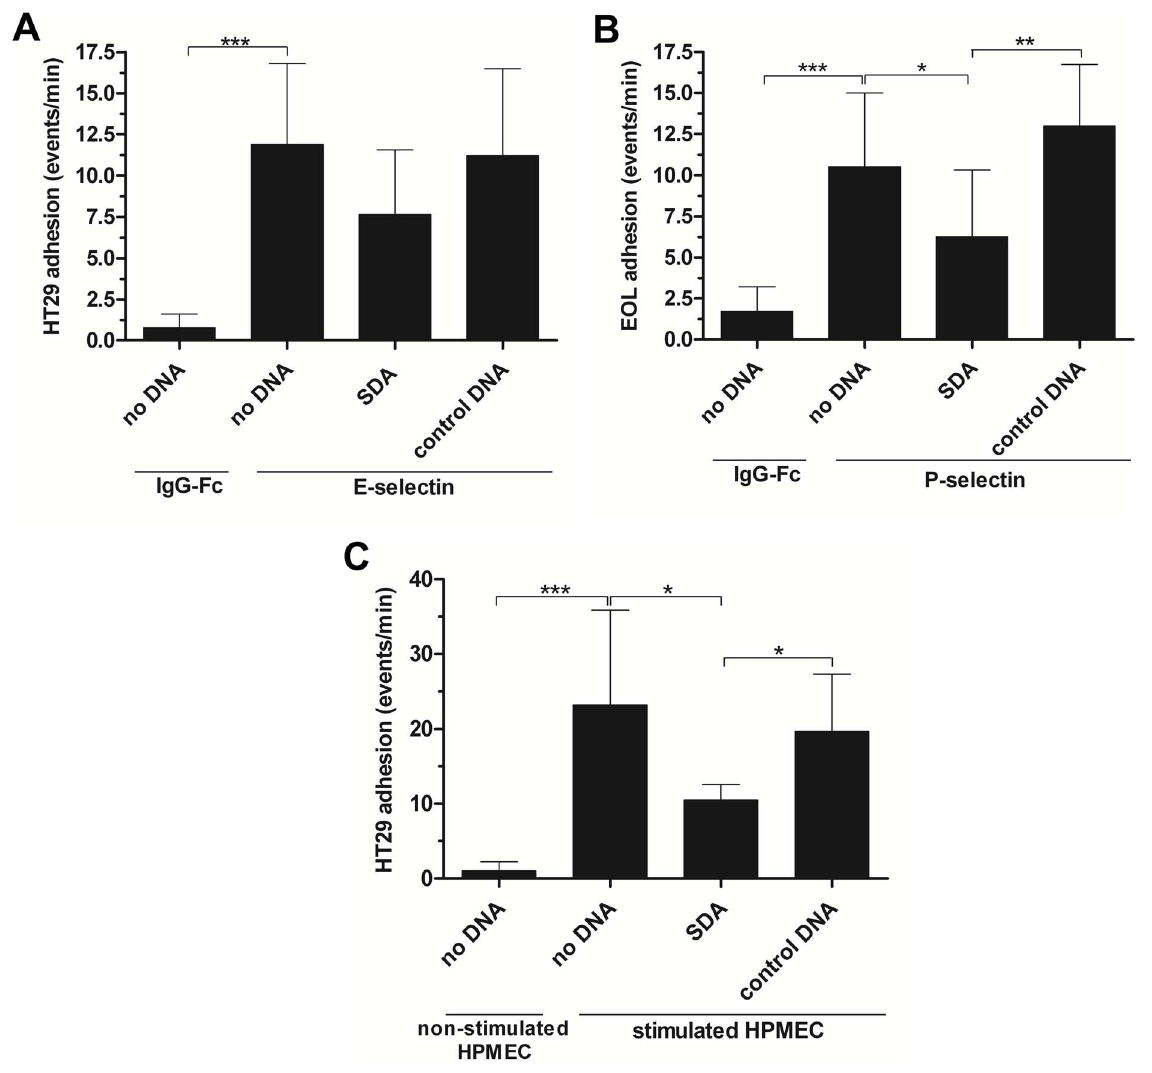
Figure 5. SDA inhibited dynamic cell adhesion. Immobilized rh E- (A) or rh P- (B) selectin (0.2 m M each) as well as stimulated HPMECs (C) were incubated with 5 m M of SDA or control DNA. Selectin ligand-presenting tumor cells were perfused over immobilized proteins or E-selectin presenting HPMECs (flow rate 8 mL/h) and retaining cells were counted. SDA reduced the adhesion to corresponding cells (n=6 of overall 2 different experiments, P -values applied to the selectins). IgG-Fc control showed no adhesion effect. All P values were calculated with untreated selectins as standard (* P , 0.05, ** P , 0.01, *** P , 0.001).